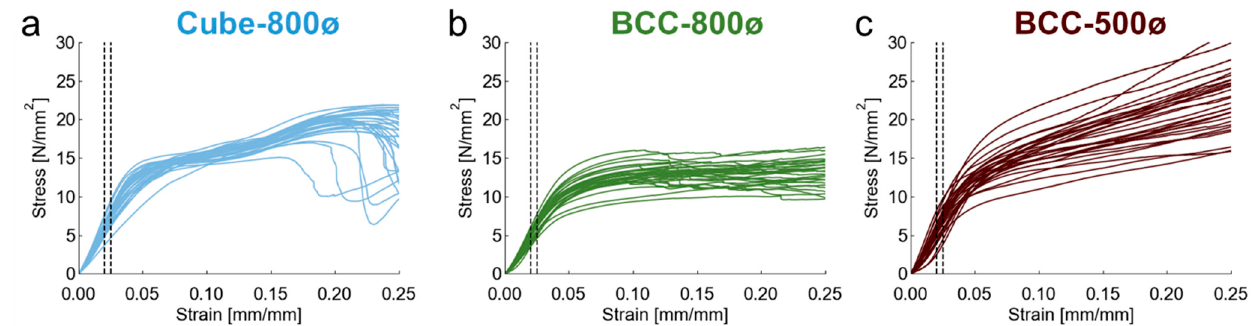
Figure 10. Stress-strain curves for ( a ) Cube-800ø, ( b ) BCC-800ø, and ( c ) BCC-500ø lattice designs for thirty samples each. Dotted vertical lines indicate boundaries for calculating elastic modulus for each curve.